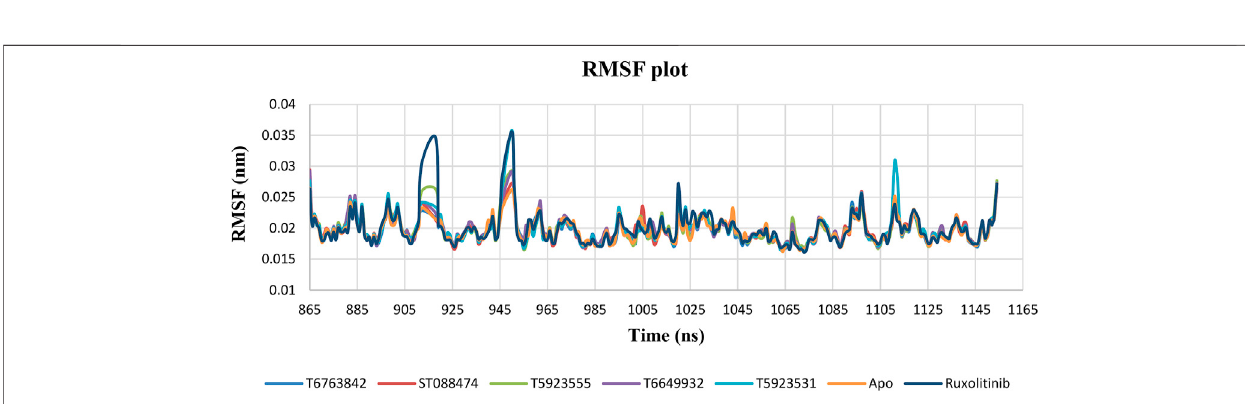
FIGURE 6 | The change in RMSF values of JAK1 residues over a period of 100 ns after binding with the lead compounds and drug.